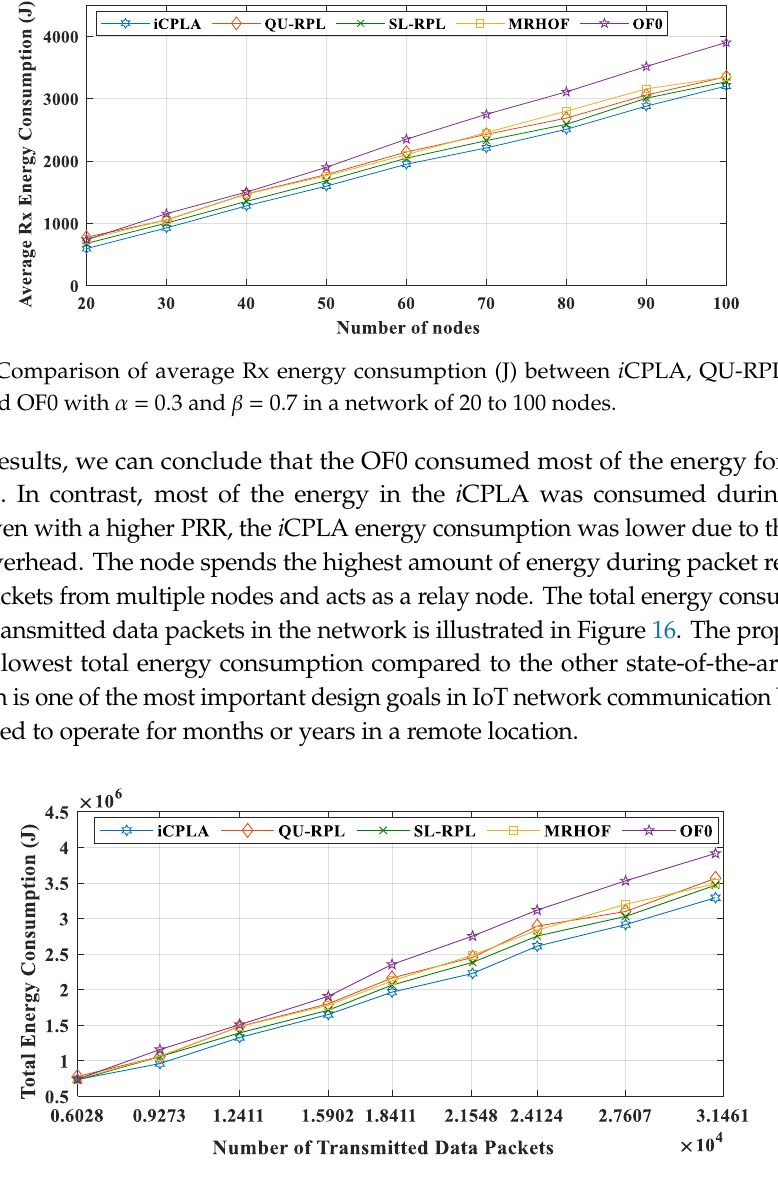
Figure 14. Comparison of average Tx energy consumption (J) between i CPLA, QU-RPL, SL-RPL, MRHOF, and OF0 with α = 0.3 and β = 0.7 in a network of 20 to 100 nodes. Sensors 2019 , 19 , x FOR PEER REVIEW